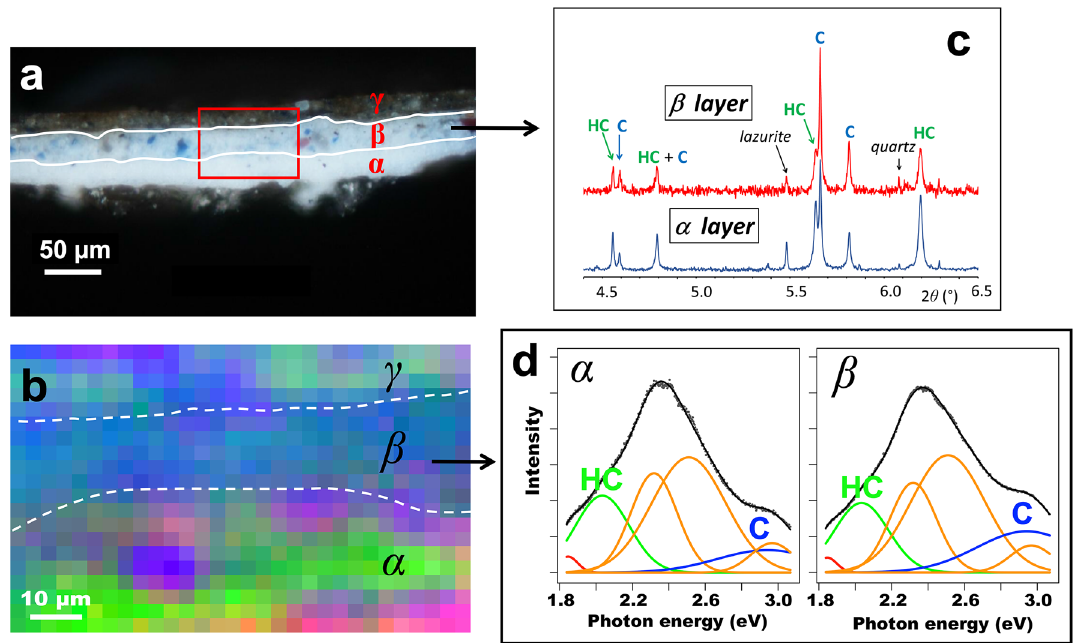
Figure 2. ( a ) Dark-field microscopy image of the St. Anne cross-section showing three layers denoted α, β and γ. The red rectangle indicates the region analyzed by SR-µ-PL. ( b ) Unfolded false-color representation of the SR-µ-PL map. The amplitude matrices of the Gaussian contributions at 1.85, 2.03, 2.94 eV are shown as the red, green, and blue channel respectively. Dashed lines indicate the interfaces between layers α, β and γ. ( c ) Zoom of a portion of the XRD patterns for layers α (blue line) and β (red line). Bragg positions for C and HC are indicated. ( d ) Average spectral fit of SR-µ-PL for layers α and β. Red, blue and green components are emission bands that were mapped out in ( b